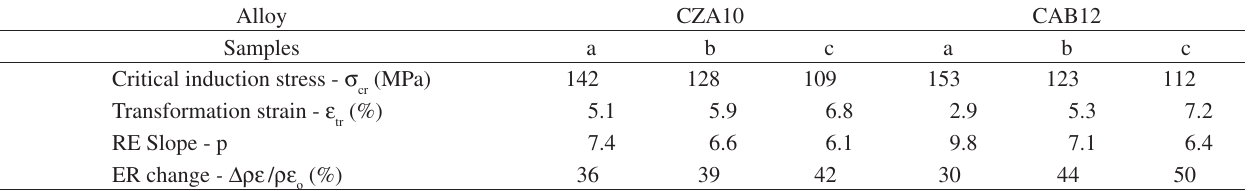
Figure 8. Micrographs of variant inducted by stress (martensite plates) with different tensile axis in Cu-Al-Be tensile samples: a) CAB12b – 0 and 2%; b) CAB12c – 0 and Table 2. Results of the crystallographic orientations different superelastic tests in the CZA10 and CAB12 samples.